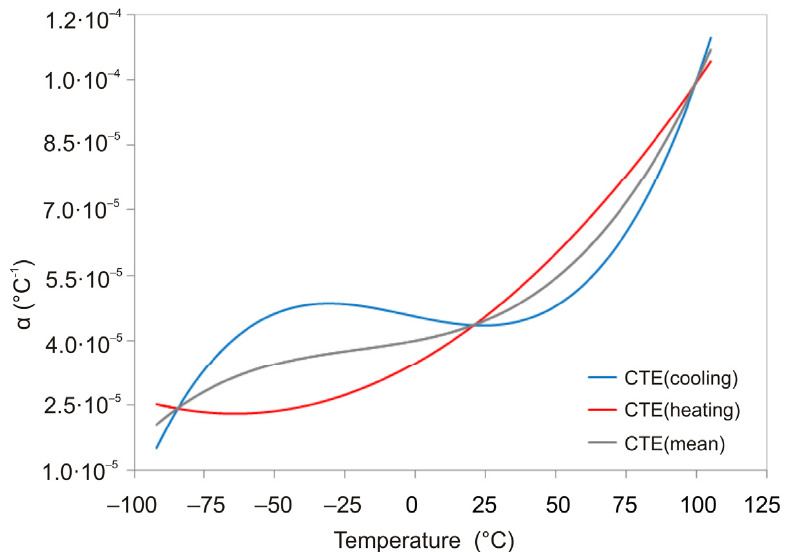
Figure 6. Temperature dependence of CTE of EPO-TEK 330 polymer during cooling (blue) and heating (red) at a rate of 2 °C/min, sample thickness 245 μ m.